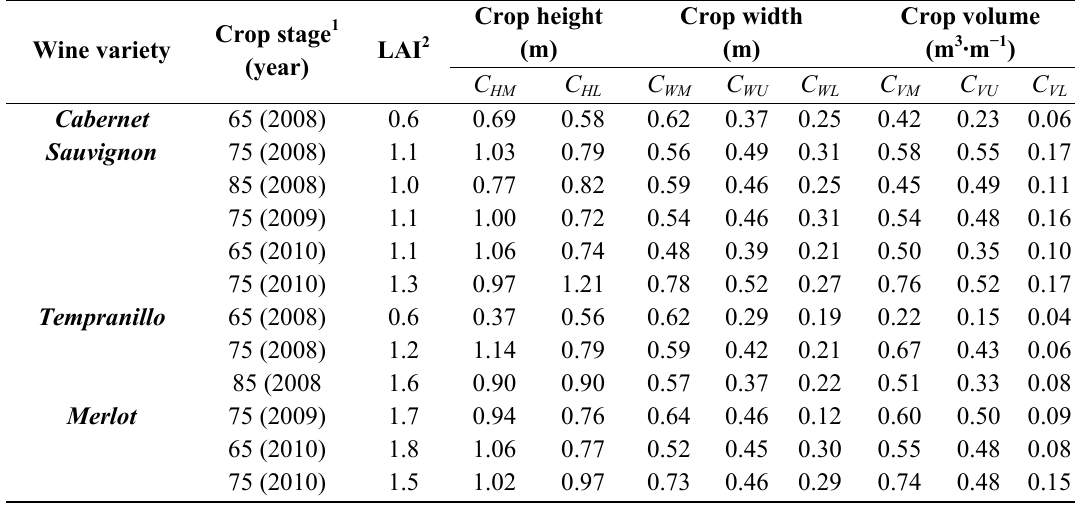
Table 1. Values of most interesting crop parameters obtained with the different measurement